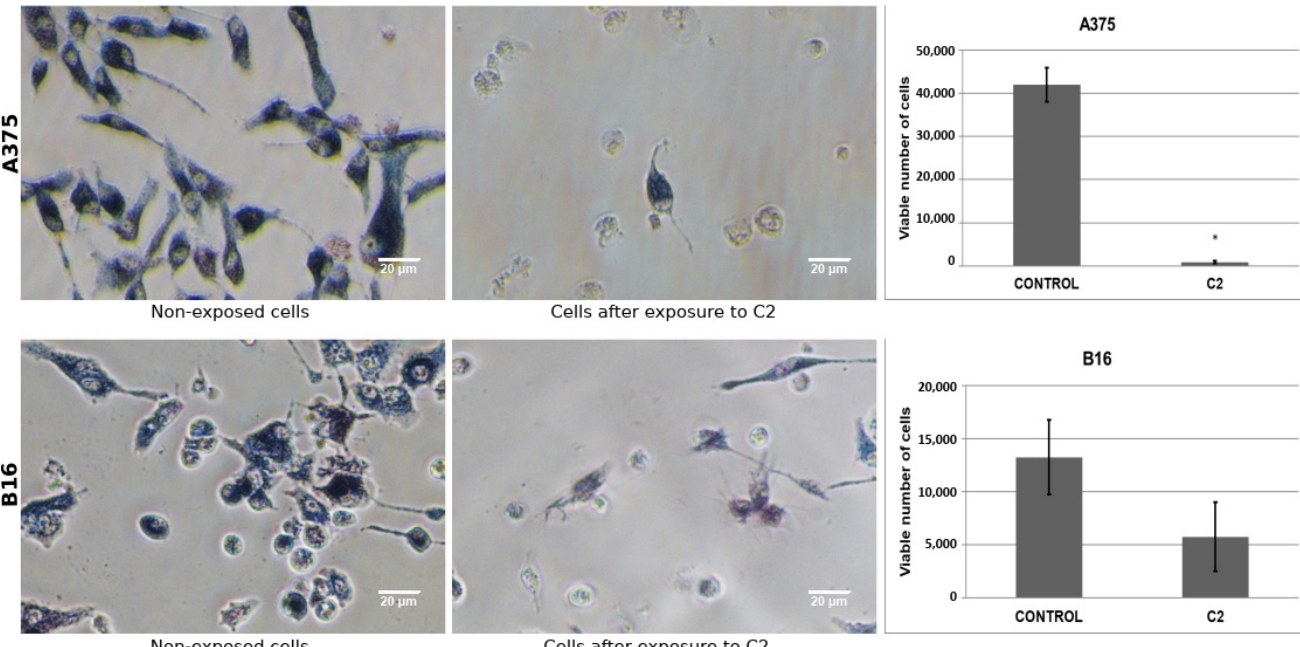
Figure 7. Effect of compound C2 on human and mouse melanoma cell lines. Human (A375, upper panels) and mouse (B16, lower panels) melanoma cells were seeded into a 48-well plate overnight and treated with C2 for 48 h. Cell viability was determined by MTT reductase activity (photographs) and trypan blue (TB) exclusion assay (bar graphs) after exposure to hit compound C2 (shown here at a concentration of 11 µg/mL for human cells and 2.75 µg/mL for mouse cells). * Statistically significant